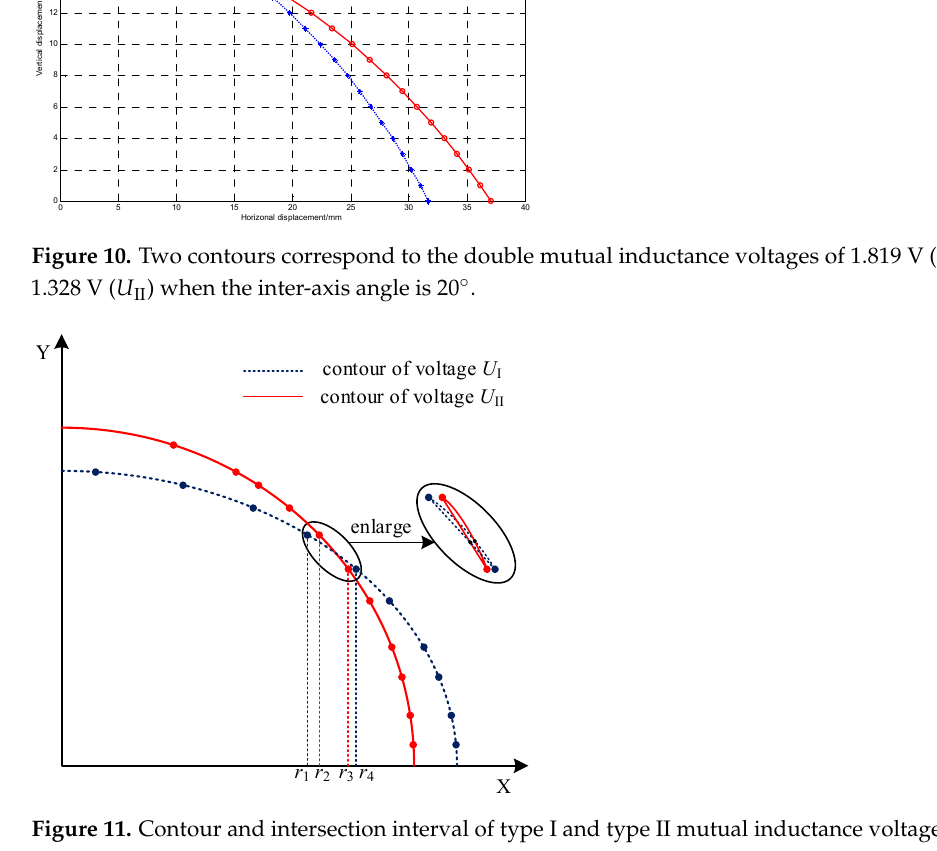
Figure 11. Contour and intersection interval of type I and type II mutual inductance voltages. In order to solve the intersecting coordinates of the double mutual inductance volt- age contours, namely, the relative displacement between adjacent sensing units, the curve expressions of type I and type II mutual inductance voltage contours need to be obtained according to the discrete points of double mutual inductance voltage equivalence. The commonly used methods are the interpolation method and the curve-fitting method. La- grange interpolation is a standard polynomial interpolation method and can calculate the curve expression passing through all discrete points according to the known discrete points. The Lagrange interpolation polynomial is as follows: